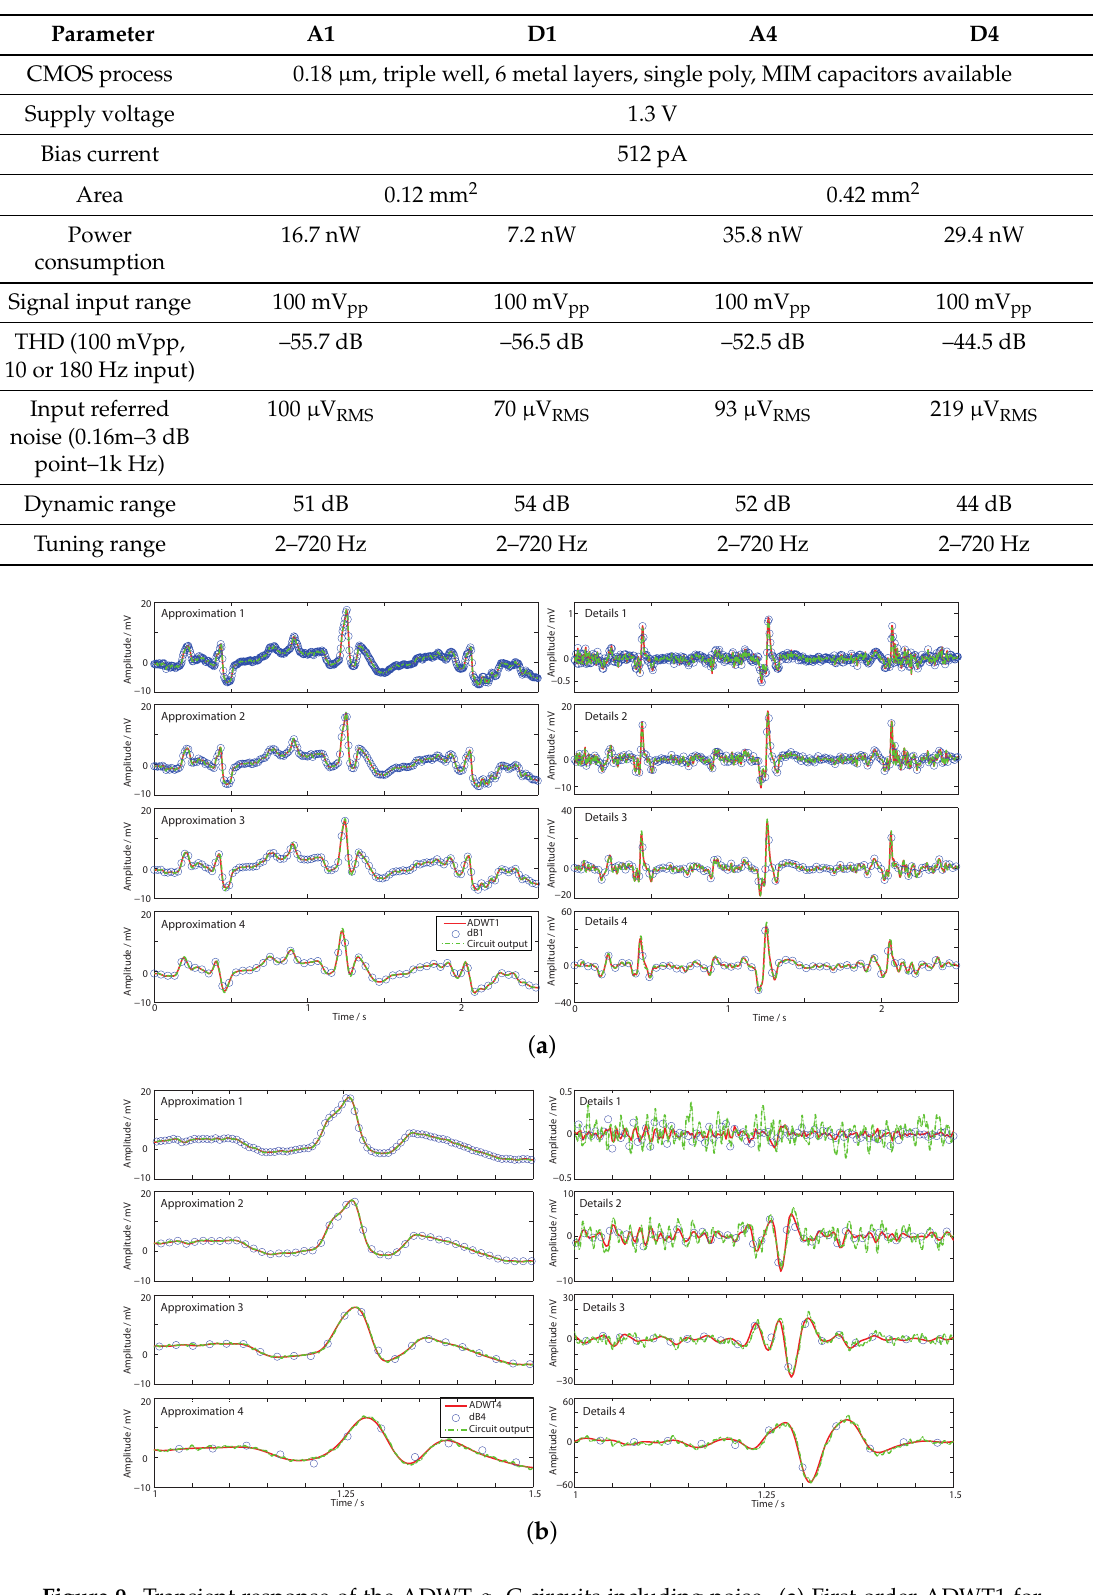
Table 5. Performance summary of ADWT filters.